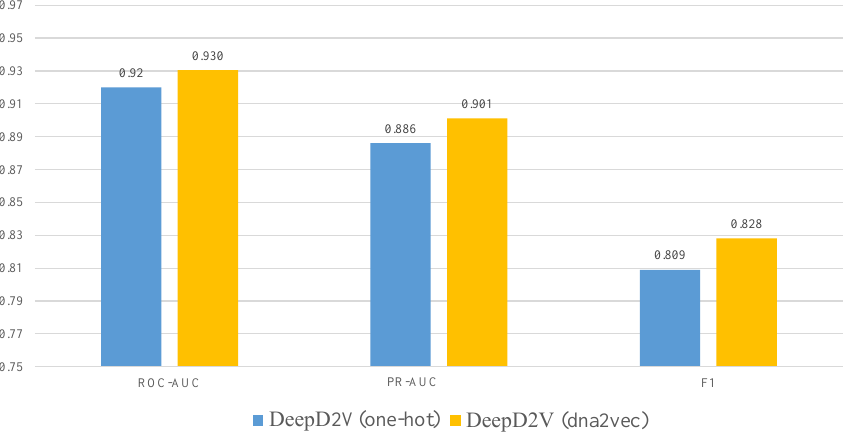
Figure 4. Performance comparison of DeepD2V using one-hot encoding vs. dna2vec on 50 in vivo datasets.